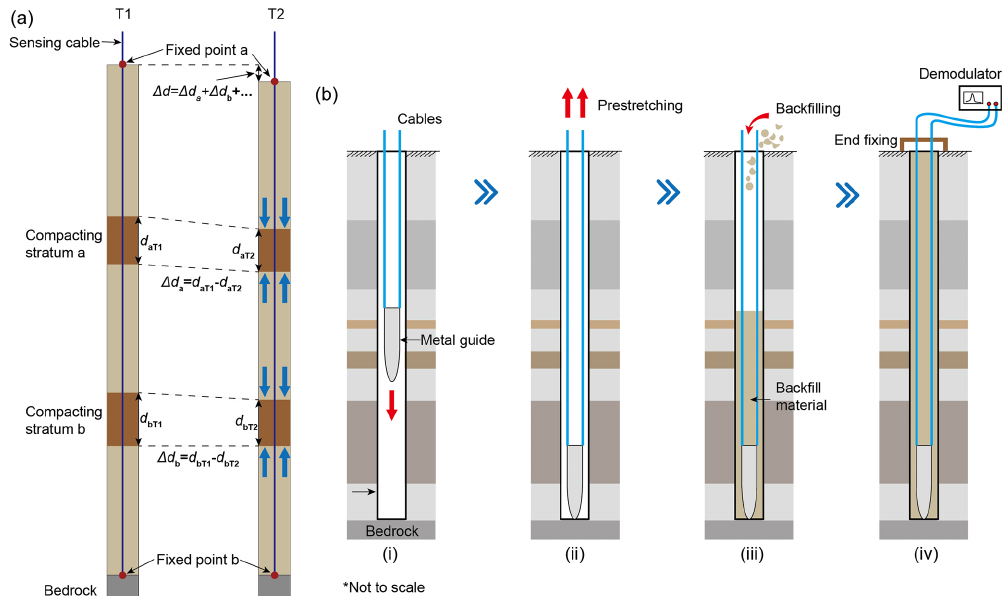
Figure 1. (a) The idea of land subsidence monitoring using DFOS, d : thickness of a stratum; T1&T2: time of data acquisition. (b) The procedure of the cable installation (cable insert → cable prestretching → backfilling with standard materials → end fixing) (Modified from Gu et al., 2020).